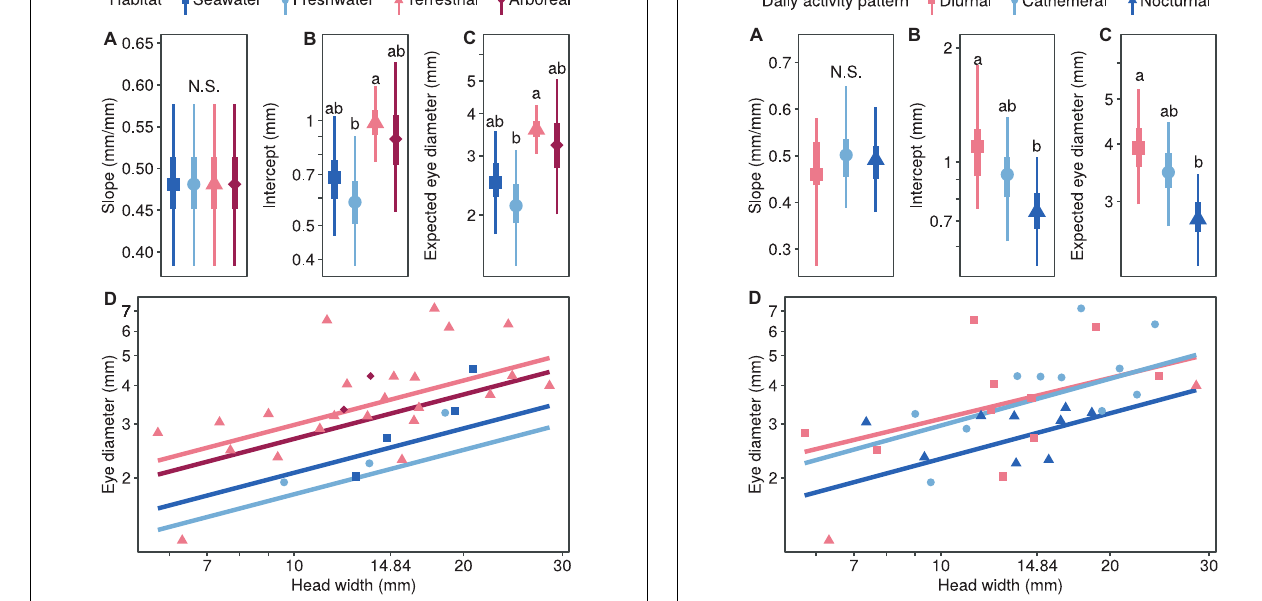
FIGURE 3 | Comparison of growth patterns of eye diameter and head width at different activity times, including allometric growth index (A) , proportionality coefficient (B) , expected eye diameter (C) and scatter diagram (D) . In subplots (A–C) , the symbols, vertical thick lines and vertical thin lines indicate the median, 50 and 95% HDI of the posterior distribution, respectively, and lowercase letters indicate multiple comparisons between groups (not having the same letter indicates a significant difference), while N.S. indicates no statistical difference. In (D) , the points indicate the mean head width and eye diameter within each